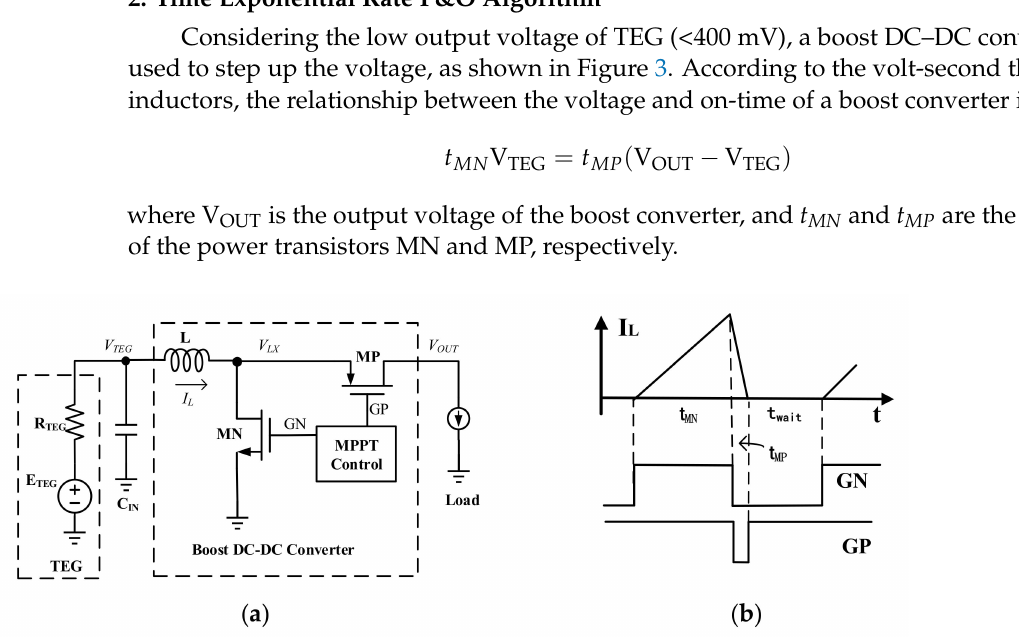
Figure 3. Proposed boost DC–DC converter: ( a ) topology architecture; ( b ) inductor current and control